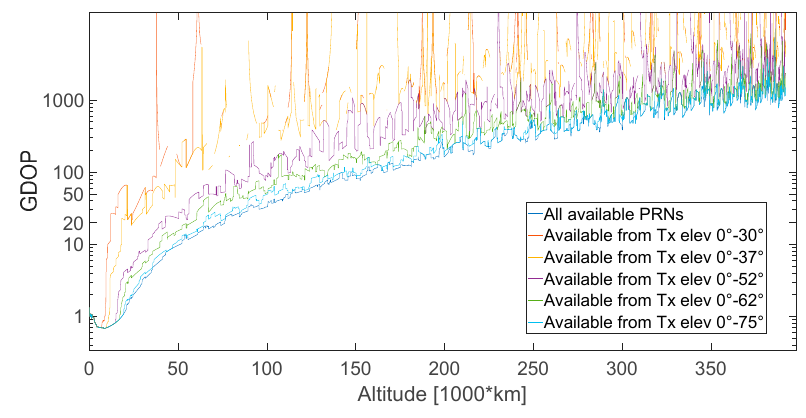
Figure 44. Zoomed-in view of Figure 43.